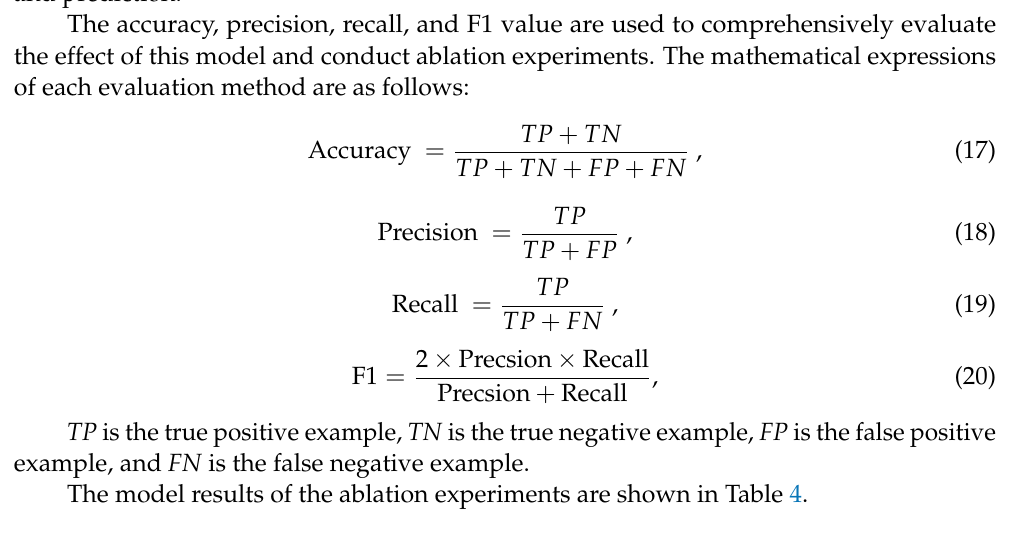
Table 4. Ablation experiment of the model prediction